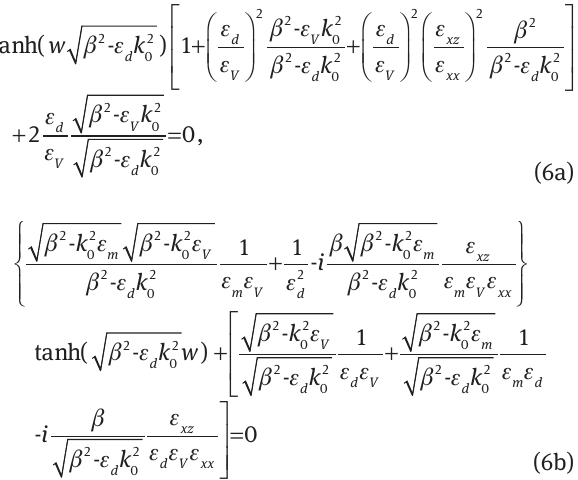
= 0.25 ω , and c p = 0 ω . Dashed lines: field distributions c p